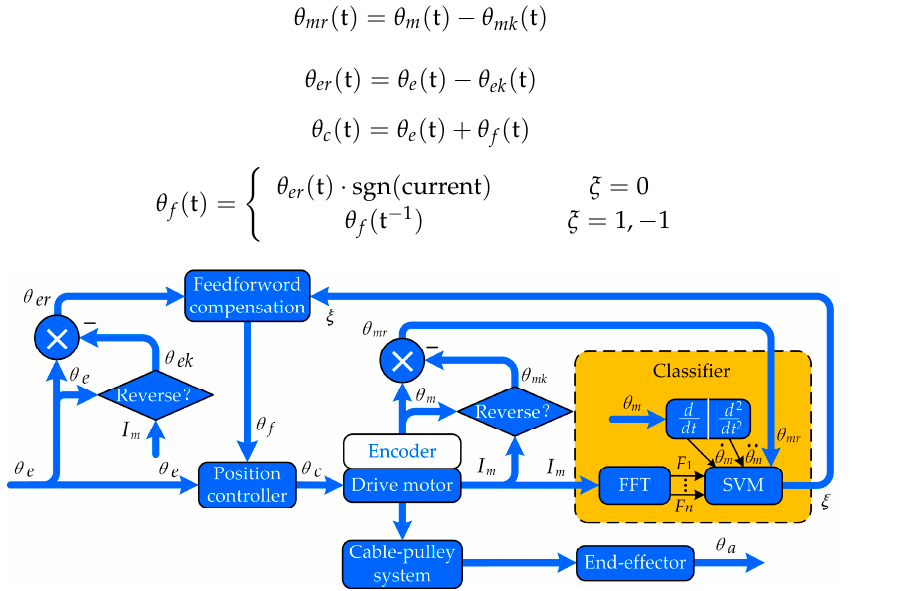
Figure 8. The position compensation control scheme based on SVM.